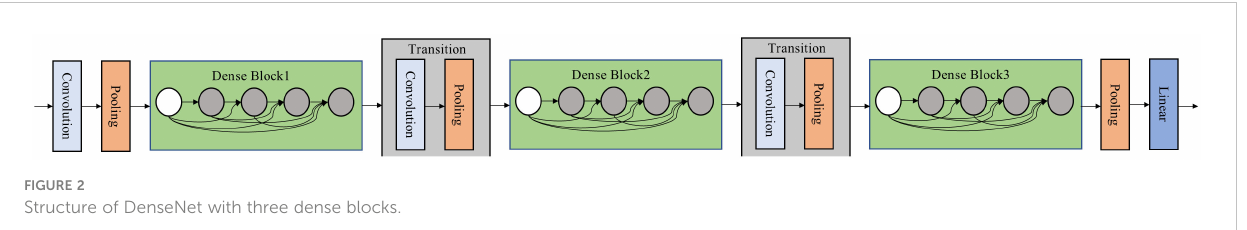
FIGURE 2 Structure of DenseNet with three dense blocks.